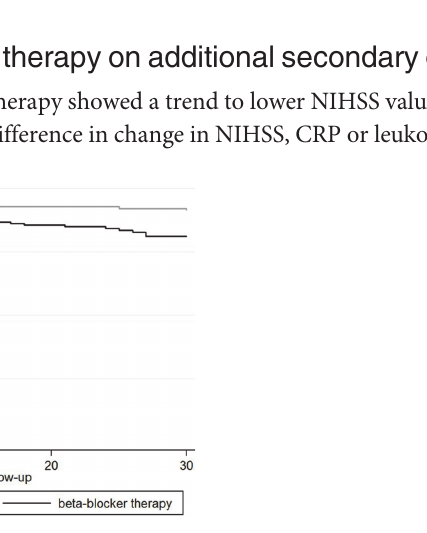
Figure 1. Kaplan-Meier plot displaying survival after stroke in patients with and without beta-blocker therapy. Patients with beta blocker therapy showed a higher 30 days mortality than those without beta blocker therapy in the univariable (log-rank test, p = 0.003) and multivariable analyses (Cox regression model, p =